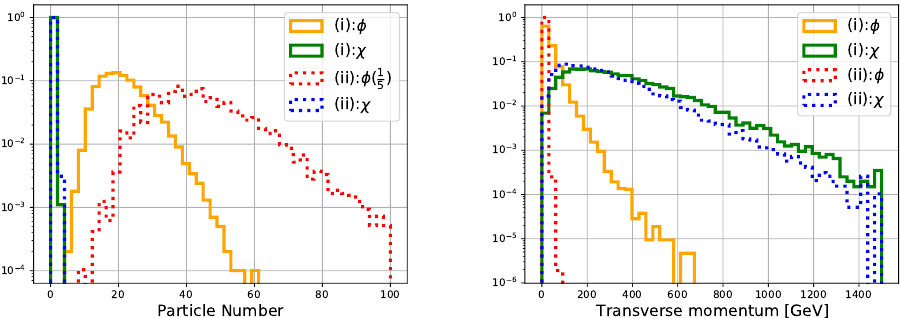
Figure 7 . The multiplicities (left panel) and p T spectra (right panel) of the singlet scalar φ (singlino χ ) in the Higgsino production and decay process for benchmark point (i) and